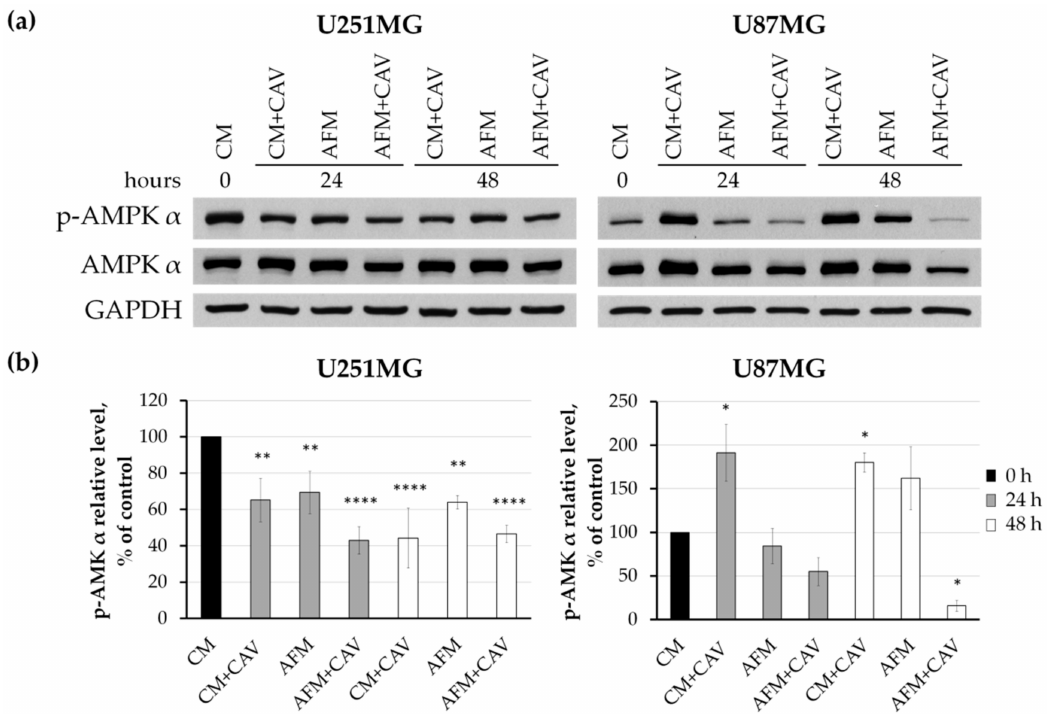
Figure 12. Analysis of the level of 5 (cid:48) -AMP-activated protein kinase AMPK α subunit. ( a ) Western blotting of AMPK α subunit and its phosphorylated form ( p -AMPK α ). GAPDH served as the internal loading control. ( b ) Densitometry of AMPK level. Graphs represent mean values ± SD from three independent experiments. * p < 0.05, ** p < 0.01, **** p < 0.0001 relative to CM (control,